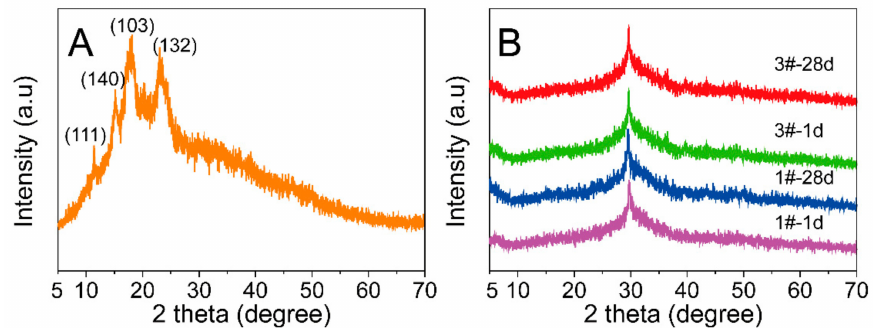
Figure 10. XRD patterns of CMS ( A ) and AAM coatings with di ff erent content CMS at time evolution ( B ).